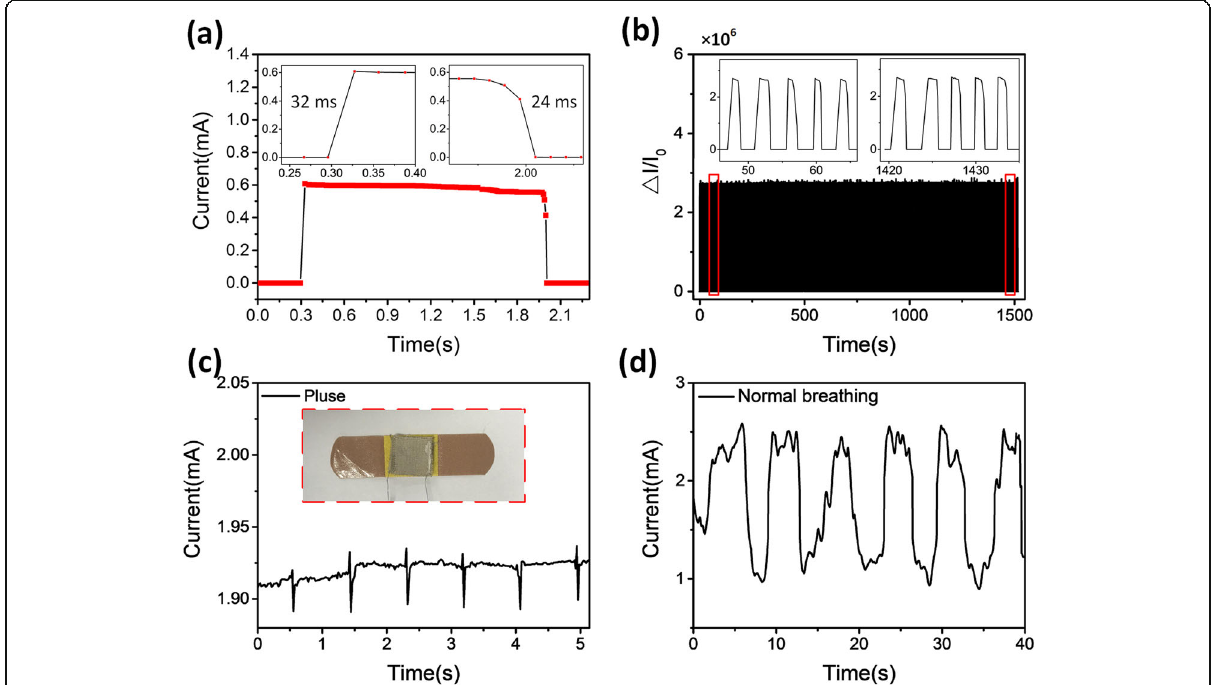
Fig. 5 a Response/release times of the device. b The cycling test of the device under a pressure of 10 kPa. c Wrist pulse signal of the human user. d The current signal responds to respiration under normal